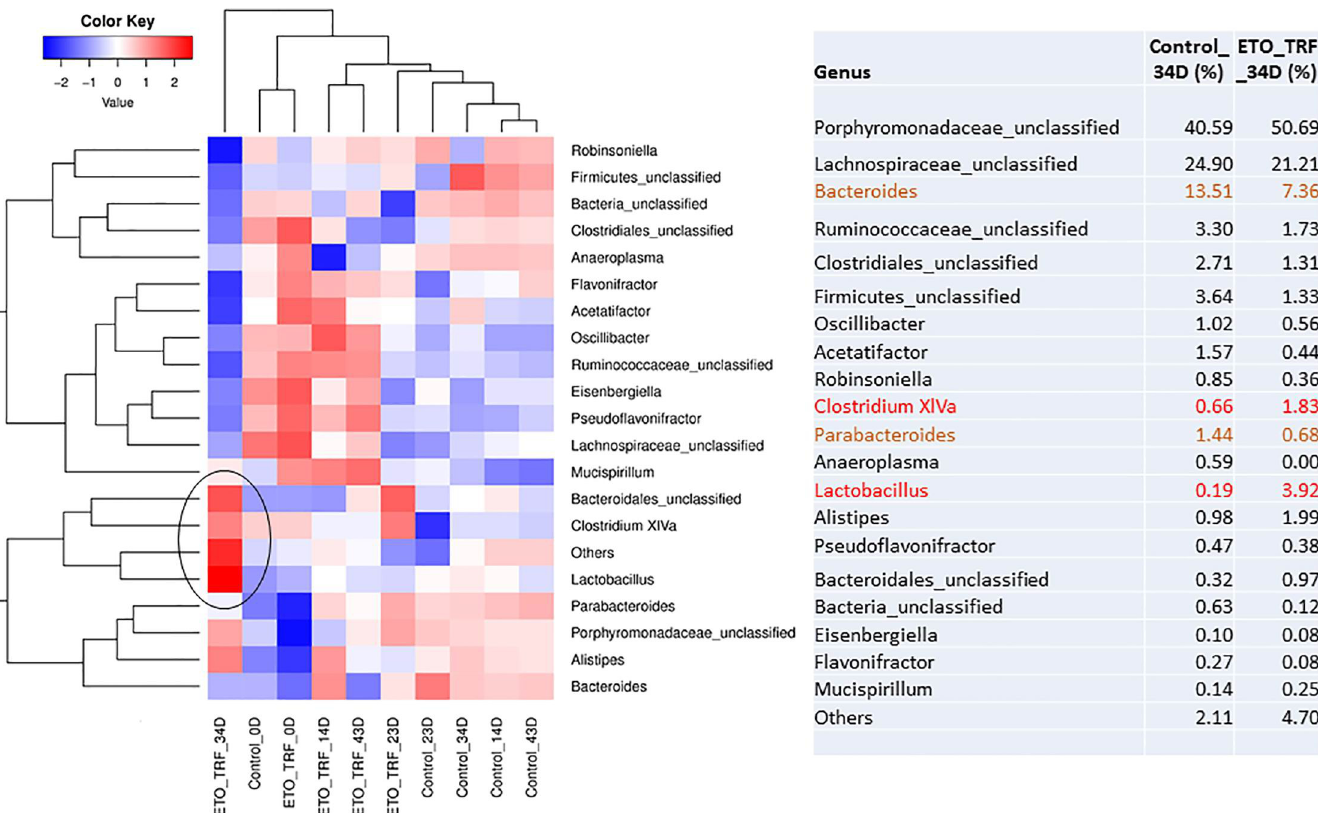
PLOS ONE | https://doi.org/10.1371/journal.pone.0229823 March 20,